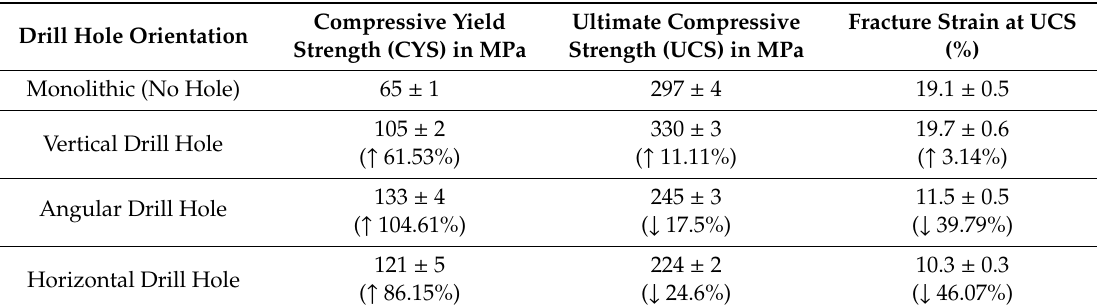
Figure 9. Experimental compression response of magnesium for different drill hole orientations. Table 2. Comparison of experimental results of compressive properties of various drill orientations to that of monolithic magnesium.